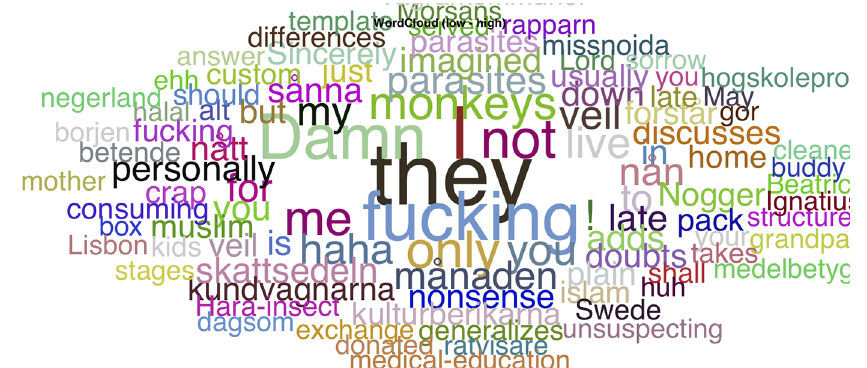
Figure 1b. Word cloud showing words with significant negative (indicative of early usage of the words) correlations between word frequency and time of writing on the forum for individual users (i.e., the logarithm of the number of days plus one since an individual user makes the first post on the forum). Colored words are significant following Bonferroni correction for multiple comparisons, and grey words are significant at p < .05. Font size is proportional to the relative correlation.